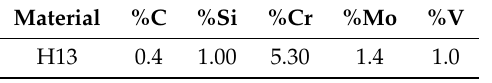
Table 6. Control process parameters and their levels. Table 5. Chemical composition of H13 tool steel [32]. Table 5. Chemical composition of H13 tool steel [32].